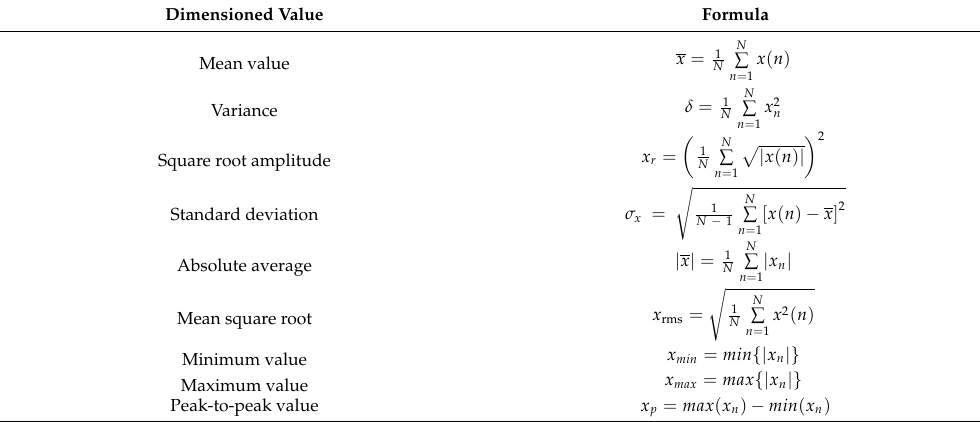
Table 1. Calculation formula of dimensional indicators in time-domain signals.